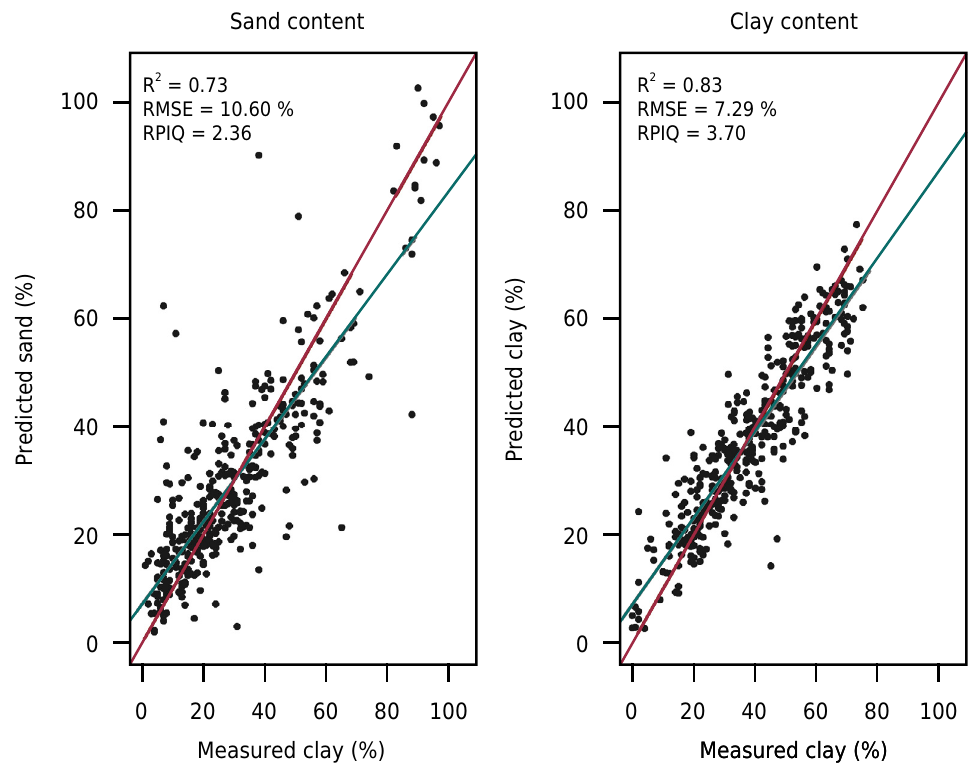
Figure 5. Assessment set of laboratory-measured versus VIS-NIR-SWIR-predicted values using Cubist (with RAW spectra) for sand and (with MSC spectra) for clay. Red line indicates 1:1